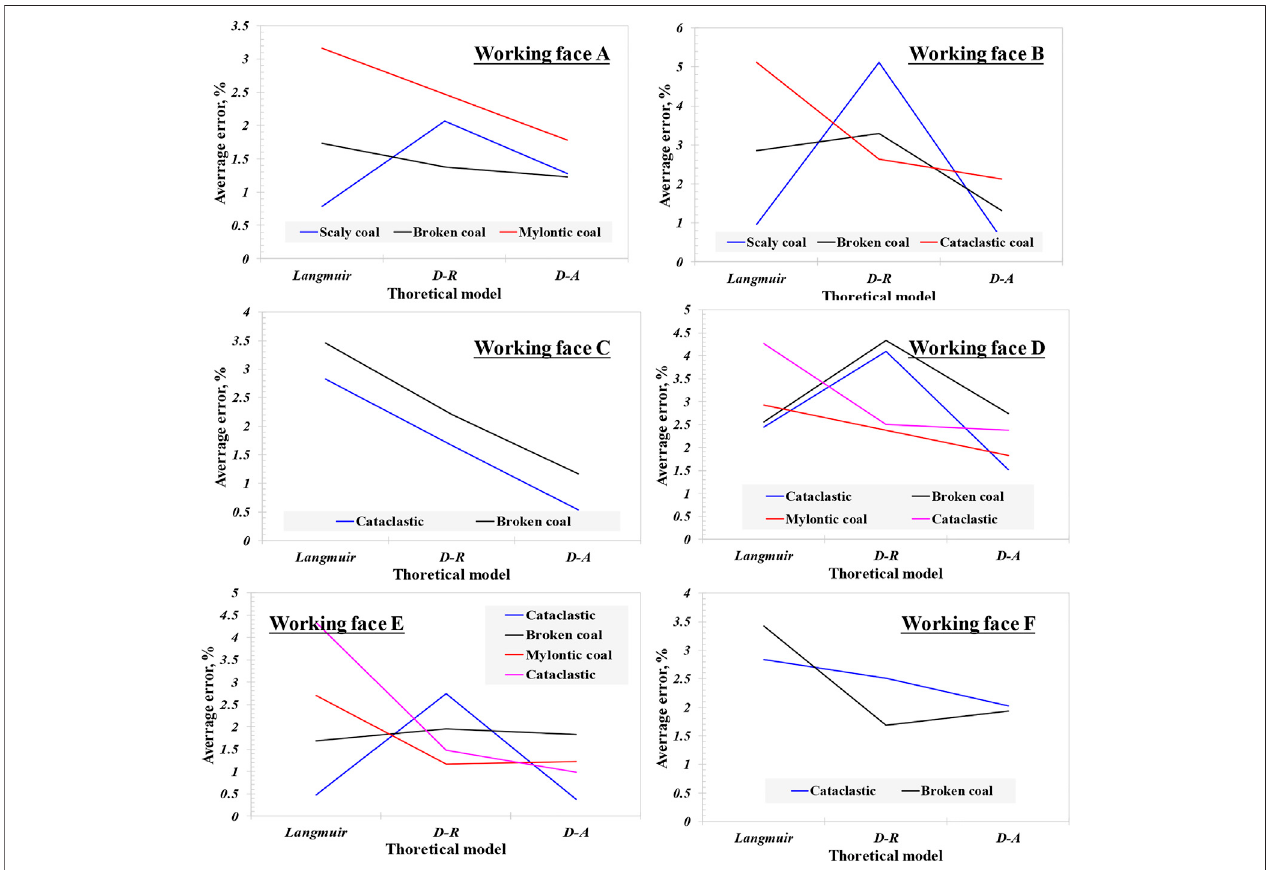
FIGURE 2 | Adsorption Characteristics of coals with different structures on the same coal rock section.